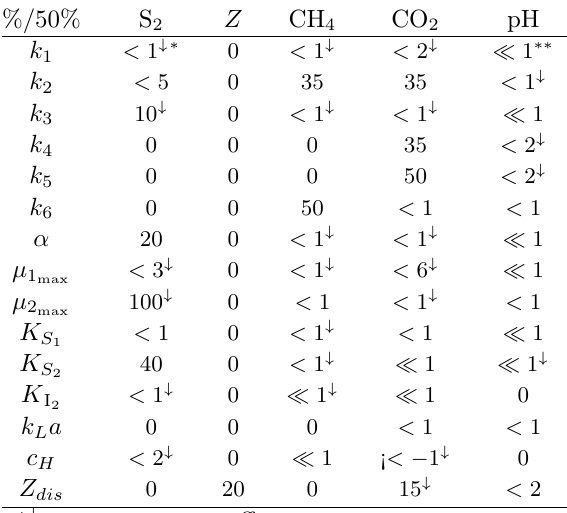
Table 12: The percent of the change on each measure- ment variable regarding 50% changes in each model